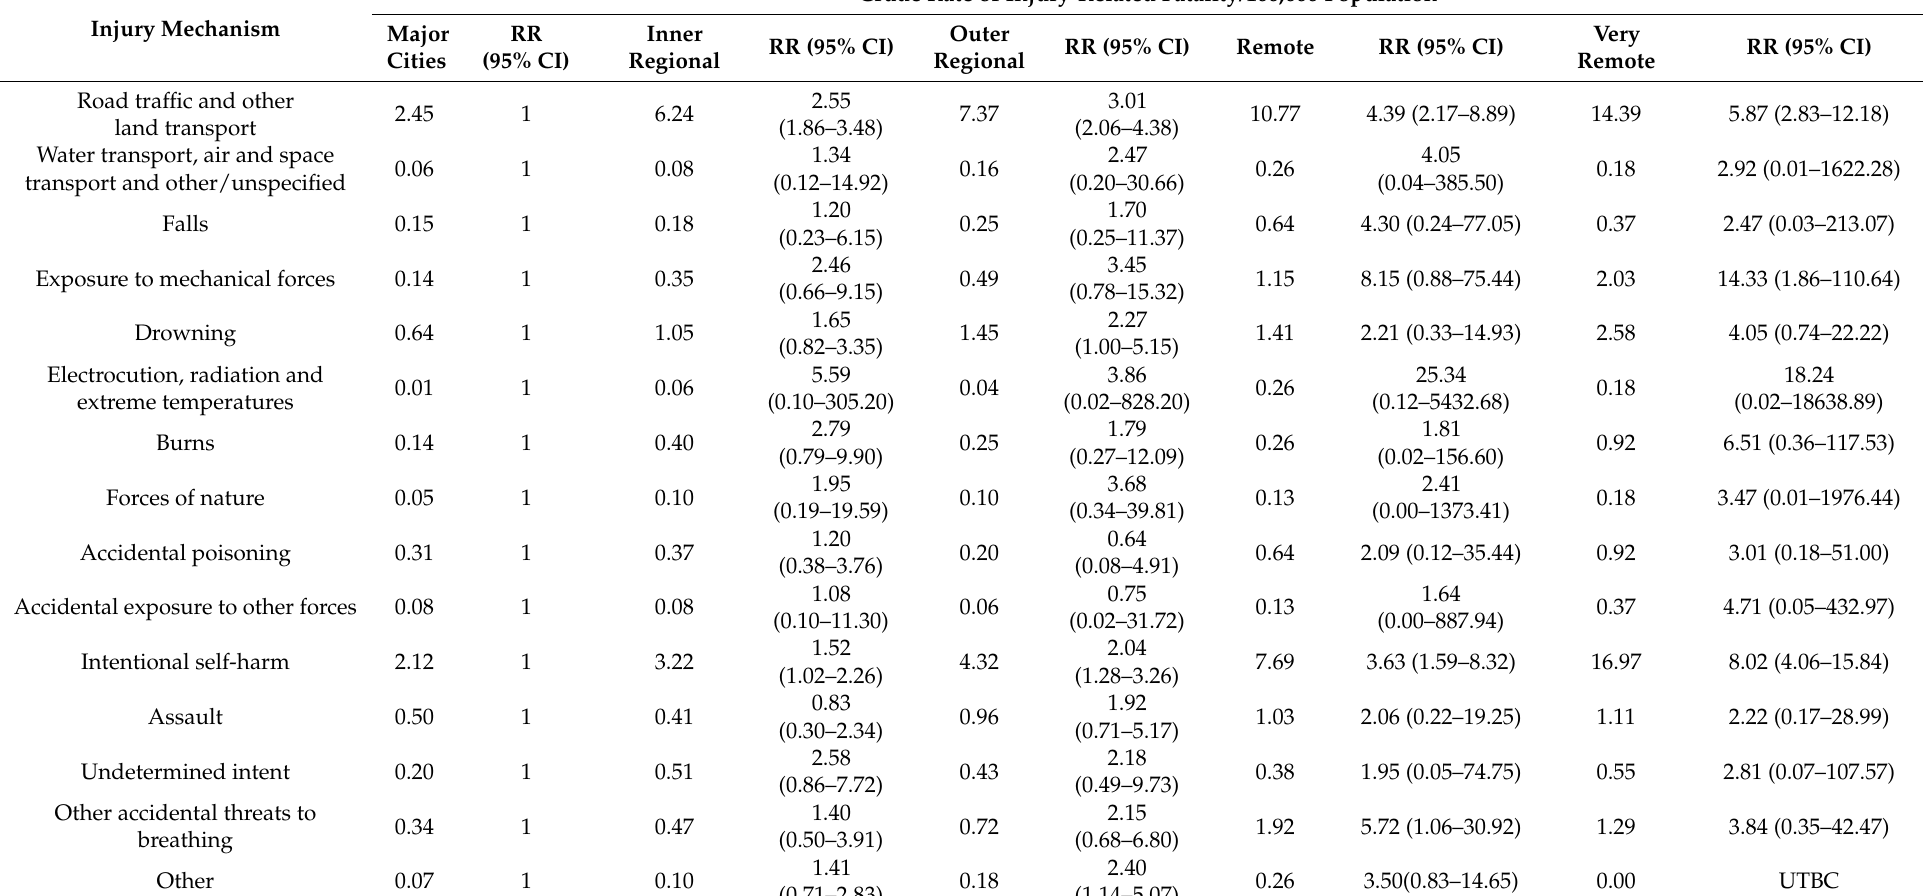
Table 5. Crude rate per 100,000 population of injury-related fatality by mechanism and remoteness classification, relative risk (RR) and 95% confidence interval (CI), among children and adolescents 0–19 years of age, Australia,